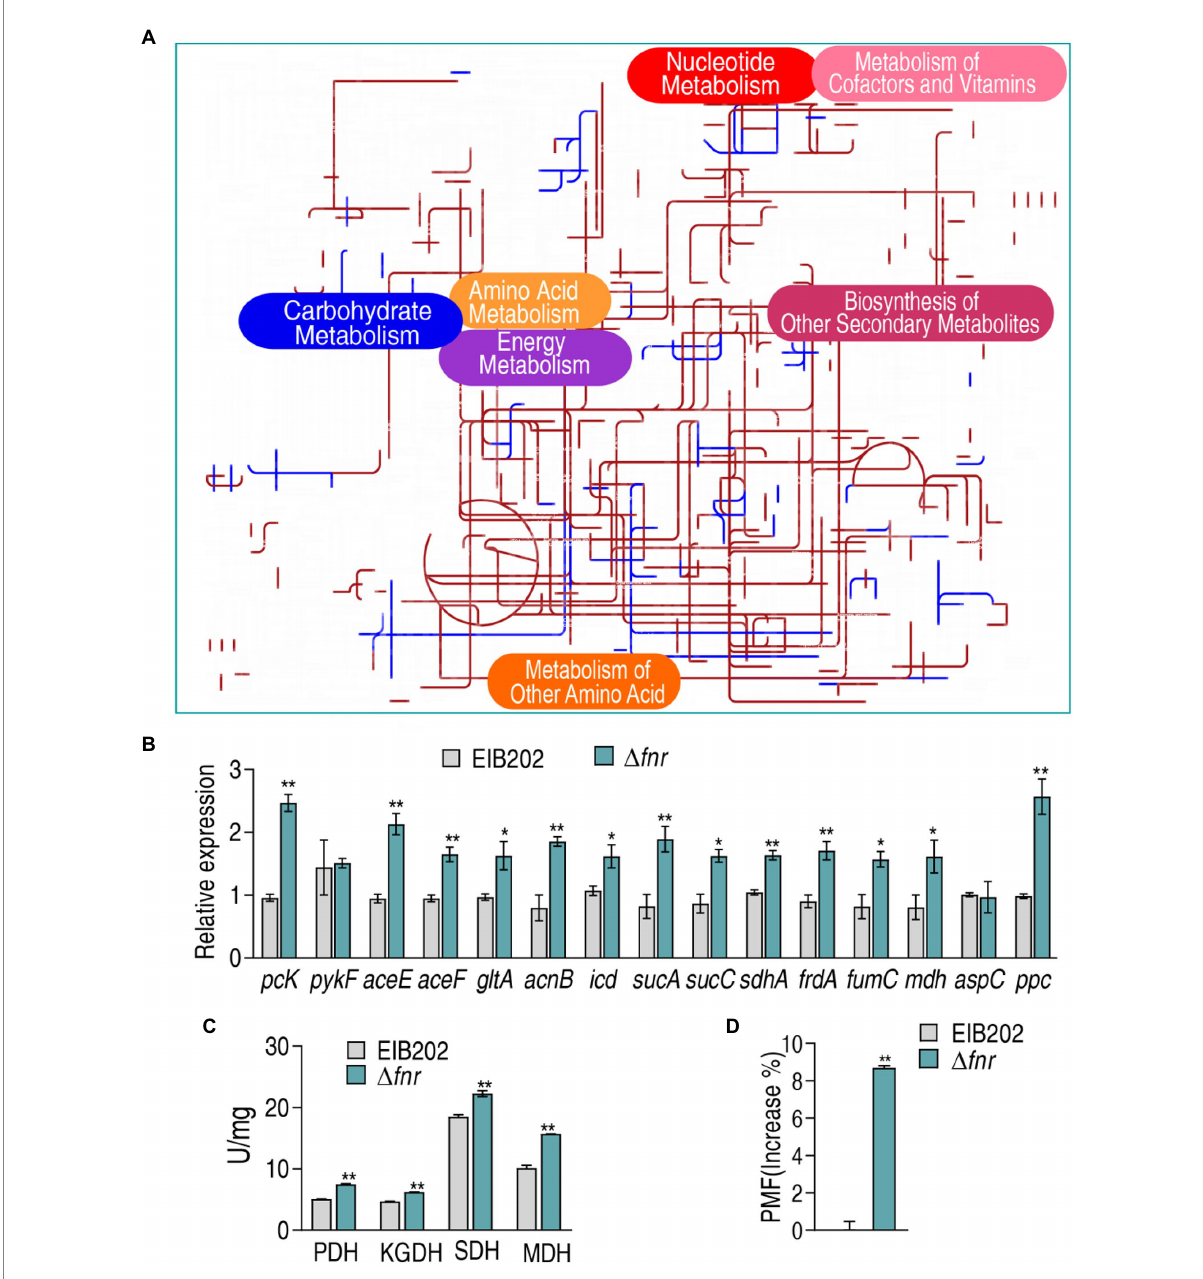
FIGURE 5 Comparative metabolic pathway analysis and enzyme activity measurement between Δ fnr and its parent strain EIB202. (A) Analysis of the metabolic profiles resulting from Δ fnr provides a better insight into the effects of 45 significant metabolites ( p < 0.05). Based on the KEGG compound (http://www.kegg.jp/kegg/compound/), metabolic network pathways in Δ fnr are further analyzed with iPath3.0 (https://pathways. embl.de/). Purple line represents increase and blue line represents decrease in Δ fnr . (B) qRT-PCR for expression of pyruvate cycle genes. (C) Activity of PDH, KGDH, SDH and MDH in EIB202. (D) Membrane potential of EIB202 and Δ fnr . Results are displayed as means ± SEM, and significant differences are identified (* p < 0.05; ** p < 0.01) as determined by Student’s t -test. At least three biological repeats were carried